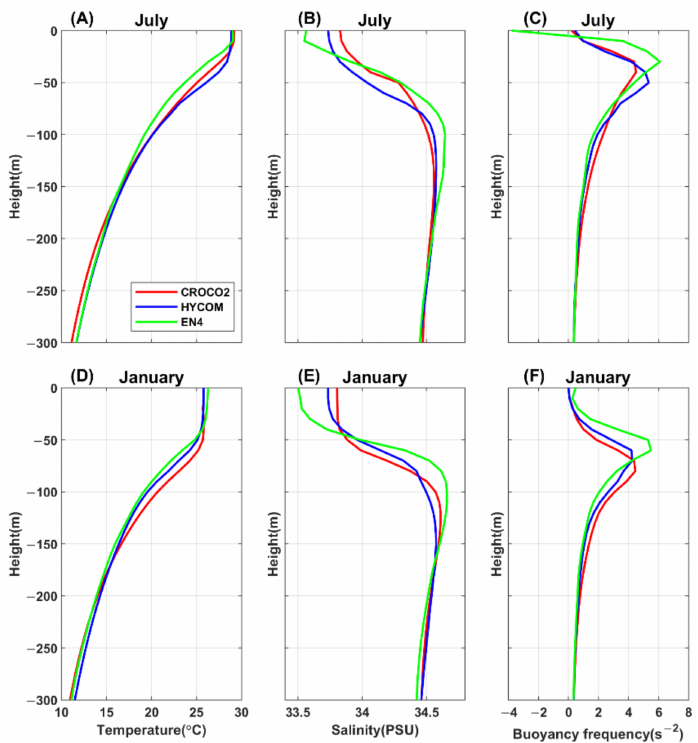
Figure 2. The monthly averaged vertical profiles of CROCO2, HYCOM and EN4. The upper (lower) row shows results in July (January), and the columns from left to right are the in situ temperature, salinity, and Burnt Vaisala Frequency. ( A ) the in situ temperature in July, ( B ) the salinity in July, ( C ) the Burnt Vaisala Frequency in July, ( D ) the in situ temperature in January, ( E ) the salinity in January and ( F ) the Burnt Vaisala Frequency in January.